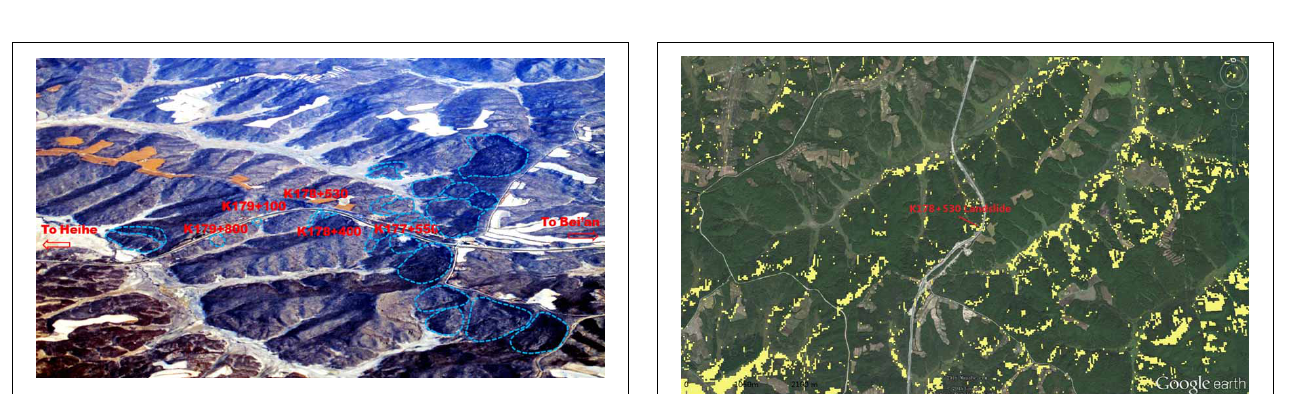
positions of points A and B, respectively, in August 2014 after